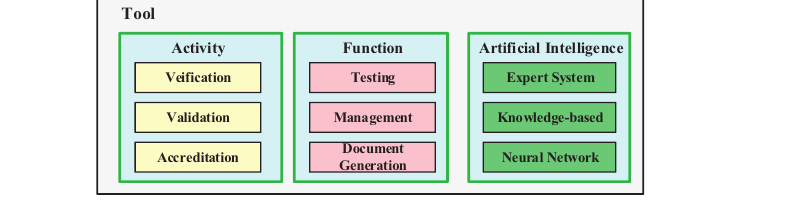
Figure 8. The classi fi cation of VV&A tools for a simulation